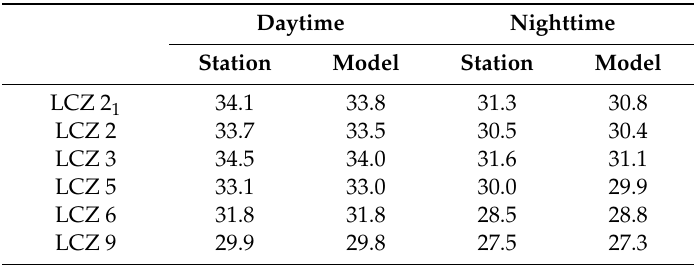
Table 11. Average observed and modeled near-surface air temperature for the urban tile of the grid cell ( T as , urb ) in Athens per LCZ (degrees Celsius) (7–11 August